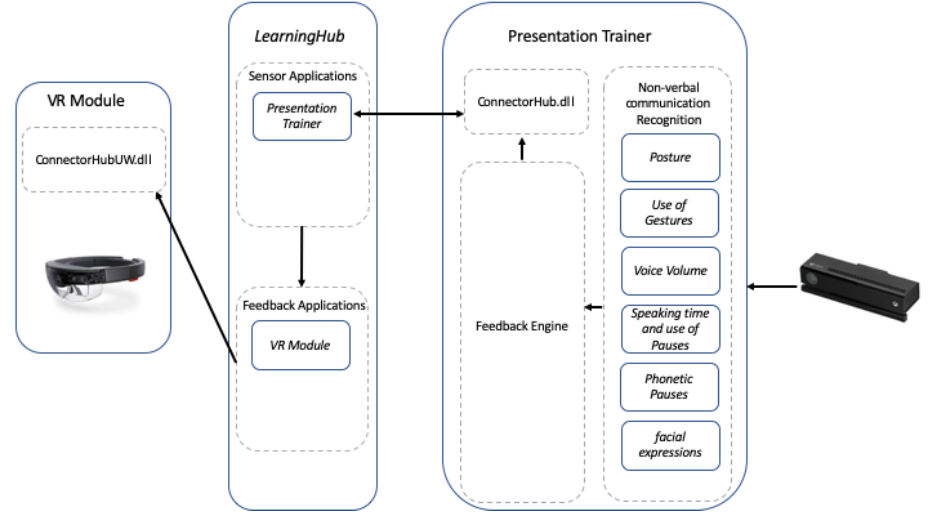
Figure 3. Block Diagram of the System Architecture: Presentation Trainer (PT), LearningHub and VR module.